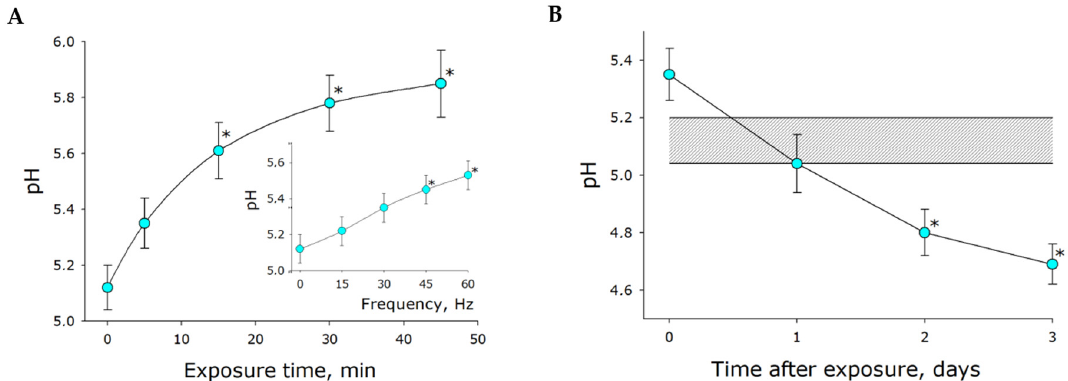
Figure 4. The effect of mechanical stress (30 Hz, 5 mm amplitude) on water pH. ( A ) The effect of exposure time on pH. The insert displays the effect of frequency of mechanical stress on the test parameter (amplitude of 5 mm, exposure time of 5 min). The measurements were made immediately after stress exposure. ( B ) Changes of pH observed for several days post-exposure. The shaded area represents the parameters of water before mechanical treatment (control). The data are presented as mean and standard error of the mean for six independent experiments. Data differ significantly from control values at p < 0.05 (*).